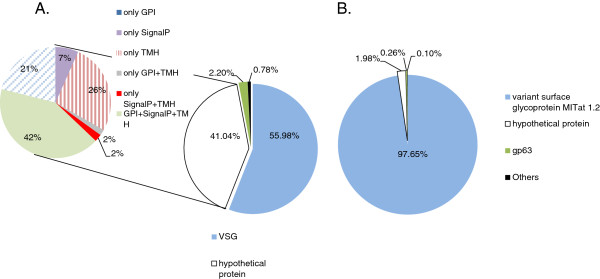
Protein Membrane composition as inferred from expression levels. A. T. vivax. B. T. brucei.